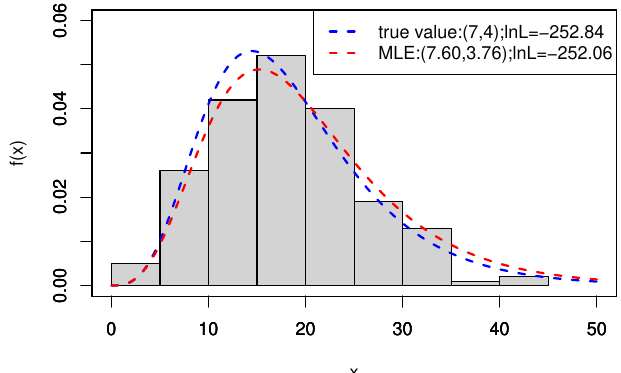
Figure 3. The true and fitted PDFs, and the density of a simulated data